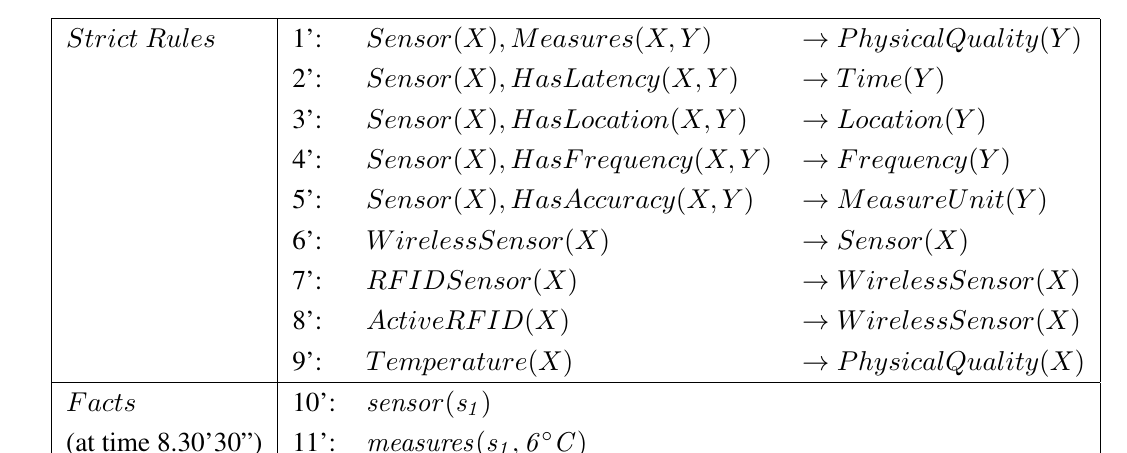
Figure 5. Translating the sensor